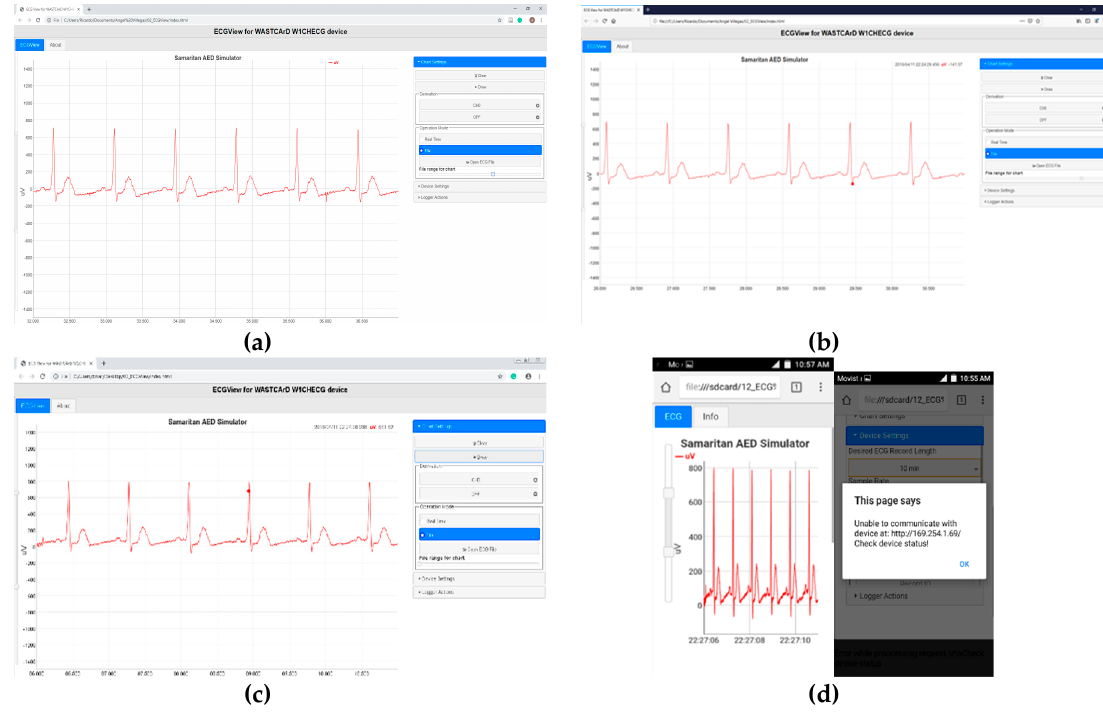
Figure 17. ECGView application running in different setups: ( a ) Chrome (PC, Win 10); ( b ) Firefox (PC, Win 10); ( c ) Chrome (Laptop, Win 7); ( d ) Android mobile.